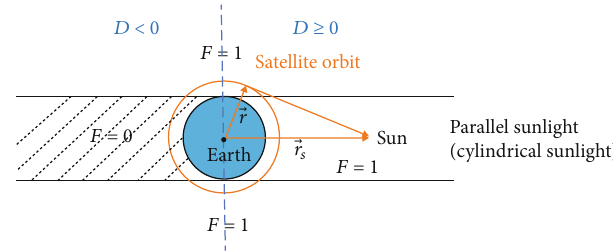
Figure 1: Relationship between sun exposure factor F and satellite position.